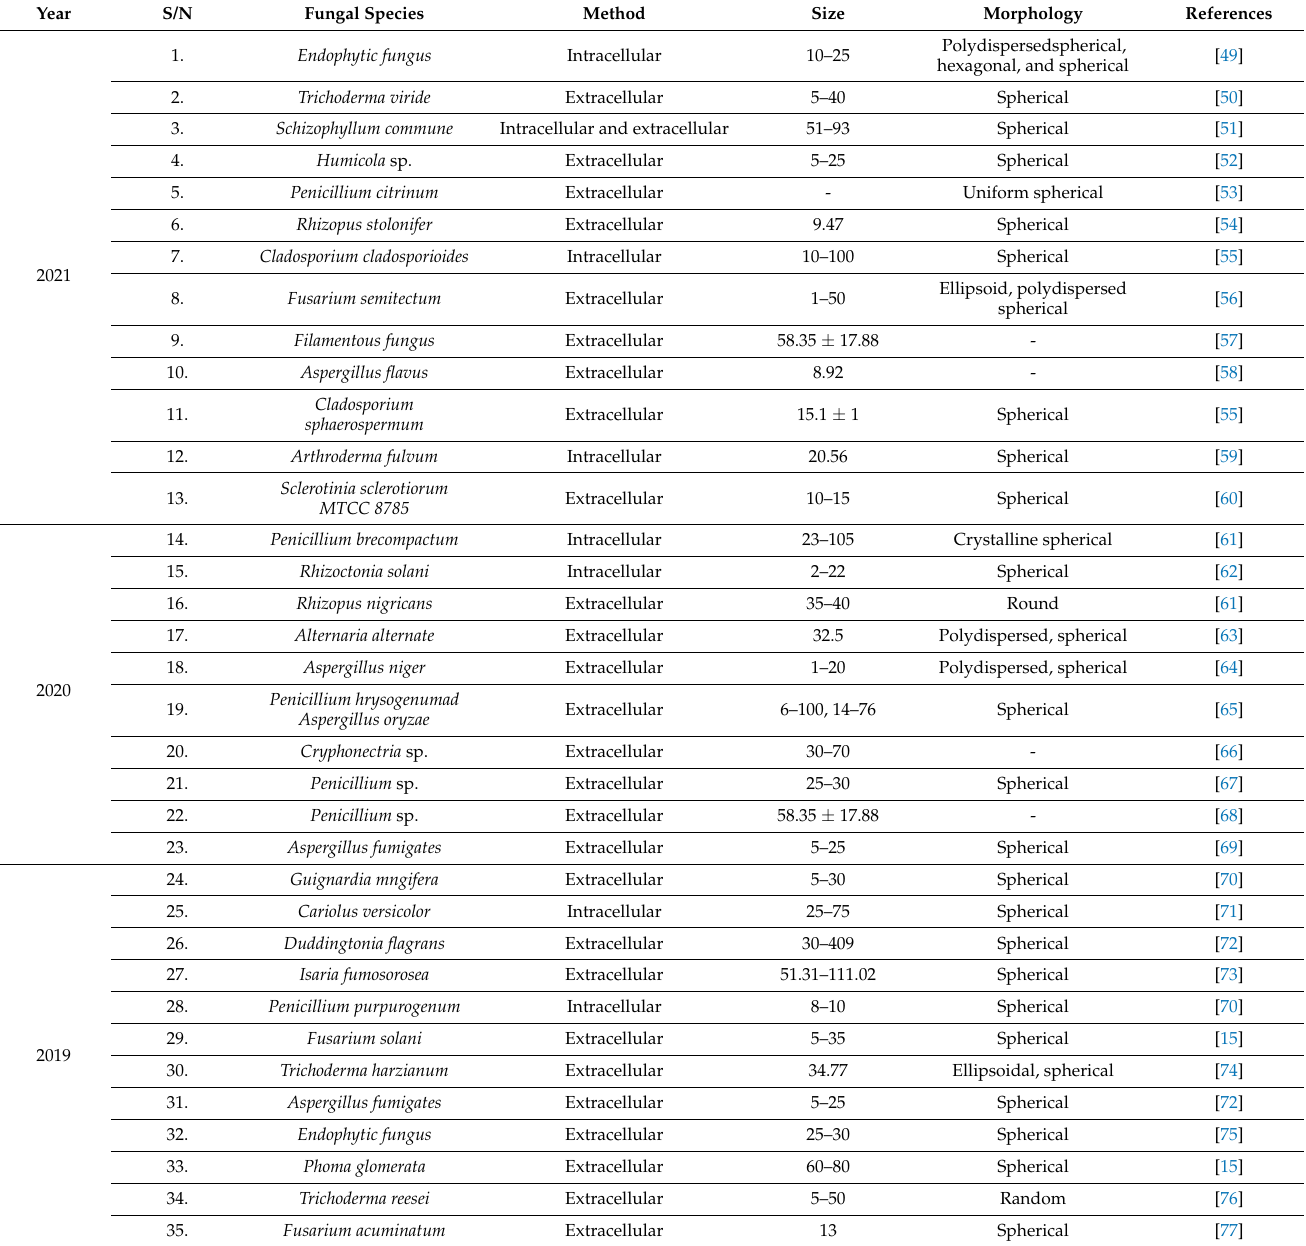
Table 2. Synthesis of metallic NPs from various fungal